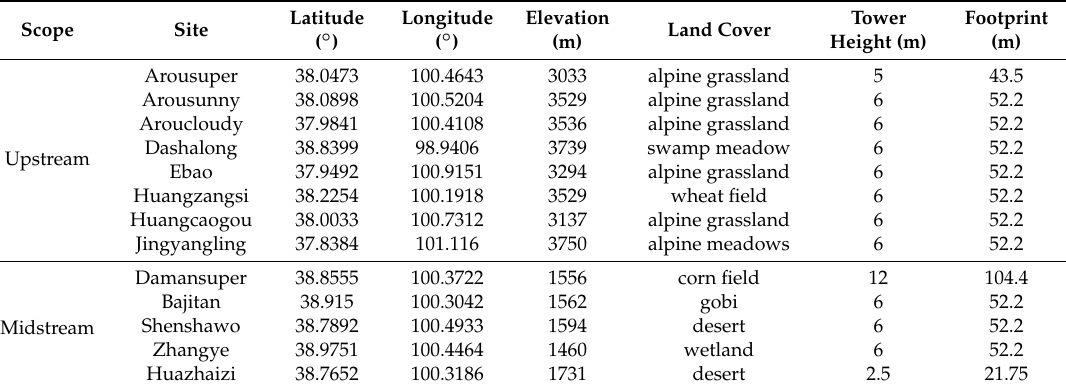
Table 1. Descriptions of the experimental